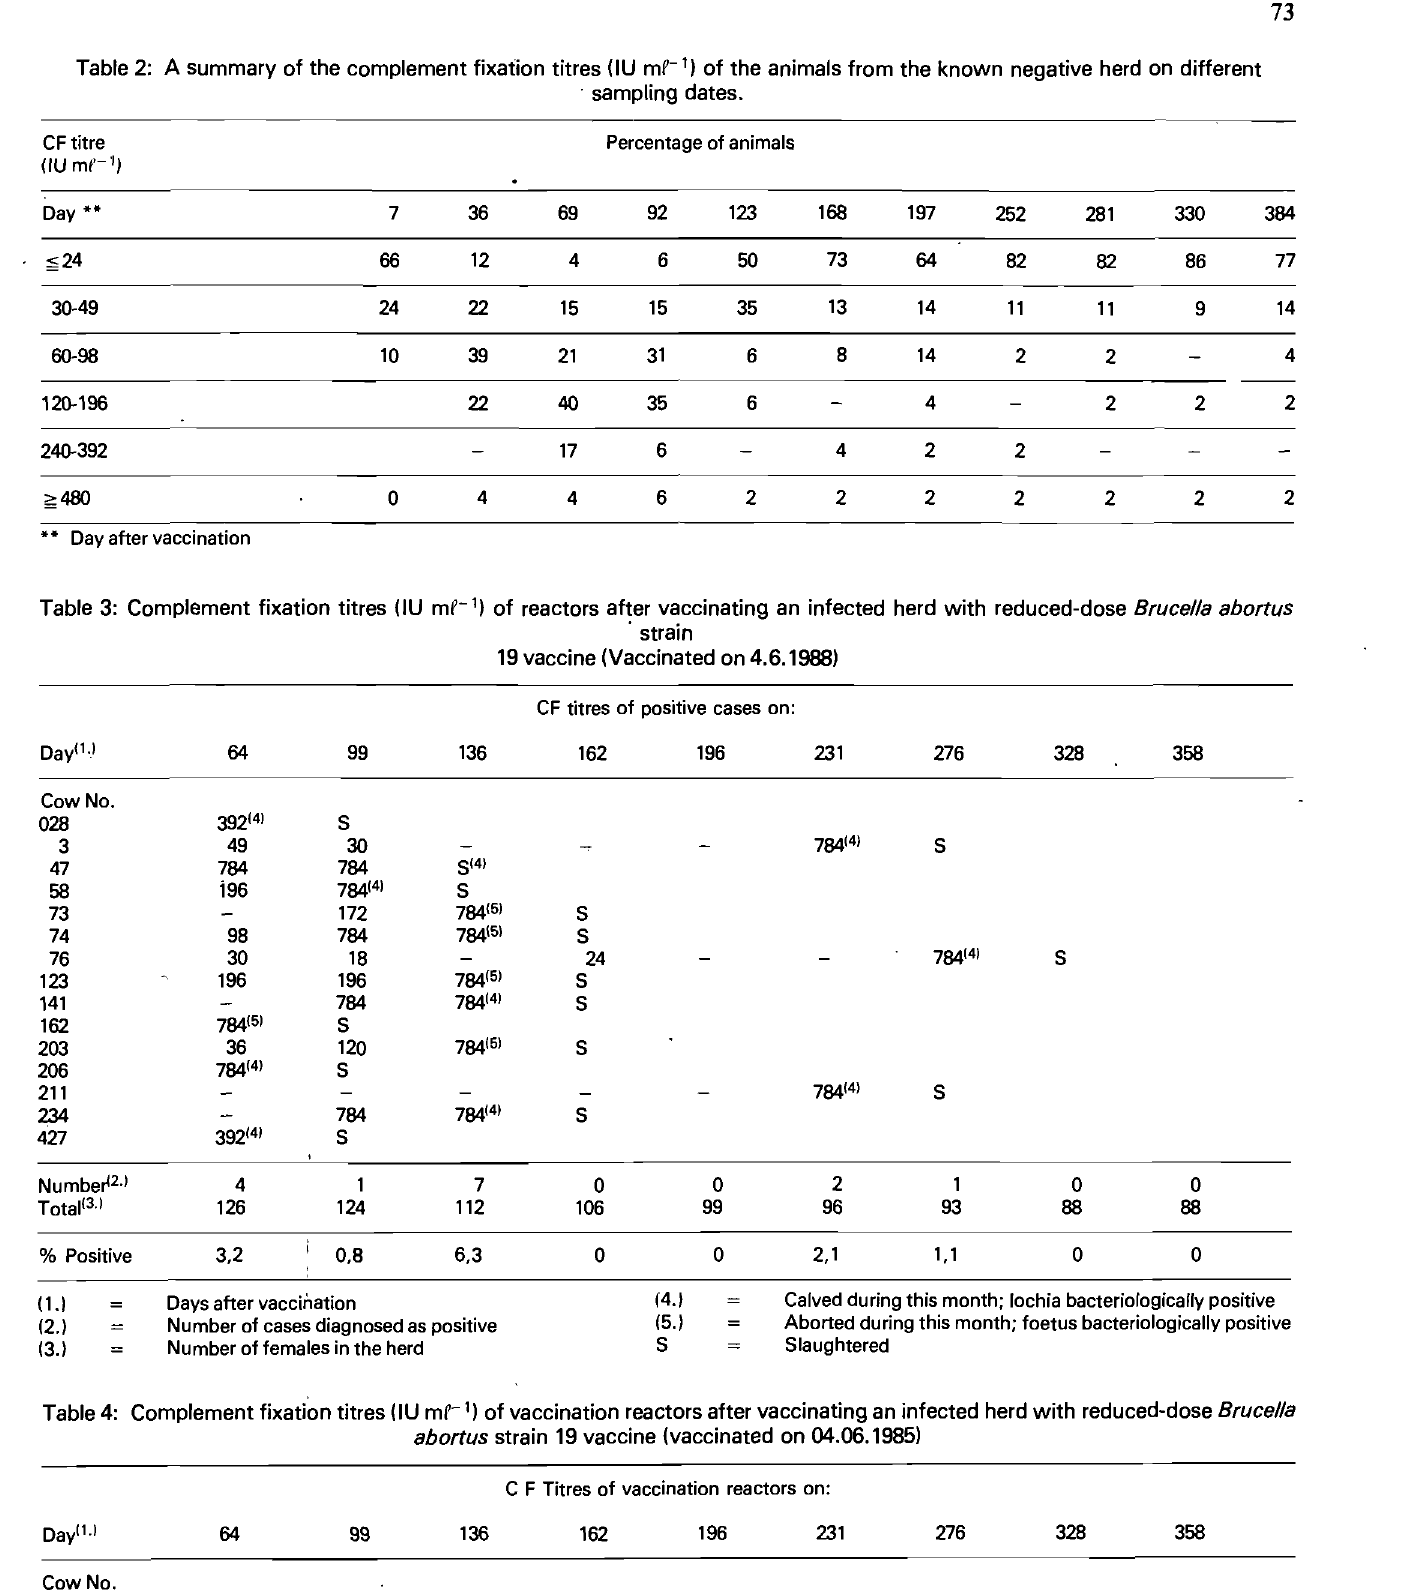
Table 2: A summary of the complement fixation tit res (lU mp-I) of the animals from the known negative herd on different . sampling dates. CF titre Percentage of animals (lU mf- .,)